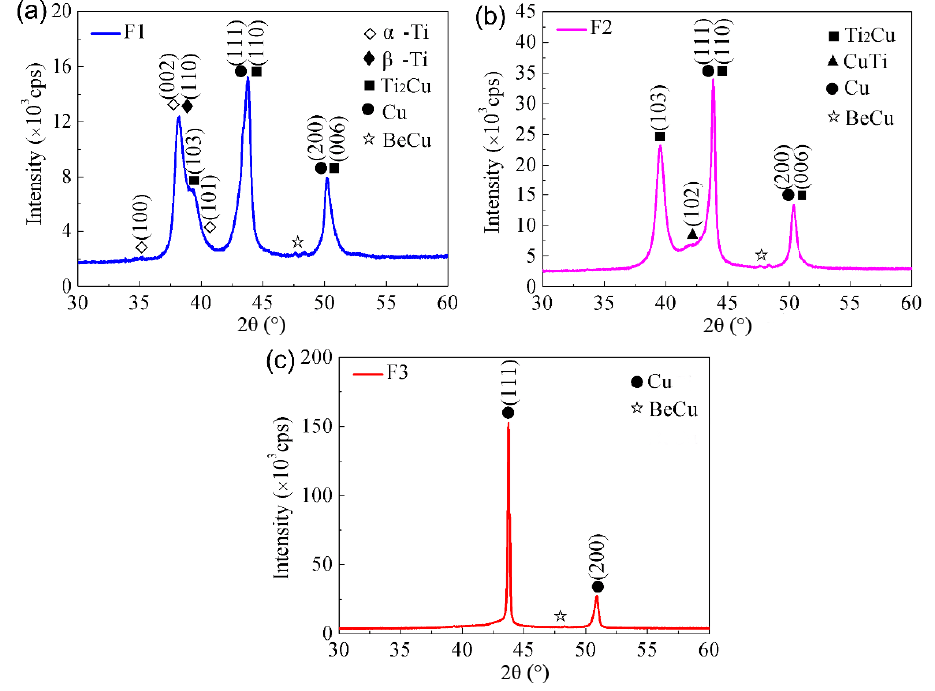
Figure 3. XRD results of the fabricated Cu-Ti film on C17200 copper alloy: ( a ) F1, ( b ) F2, and ( c ) F3.